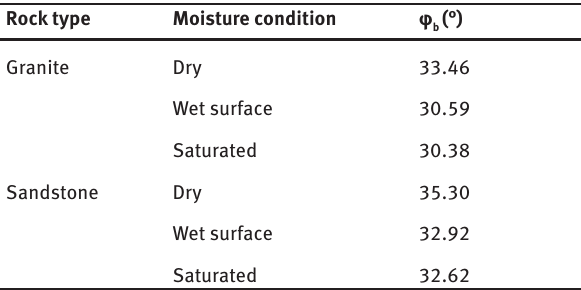
layer between the interfaces (after Braun et al. 2021)